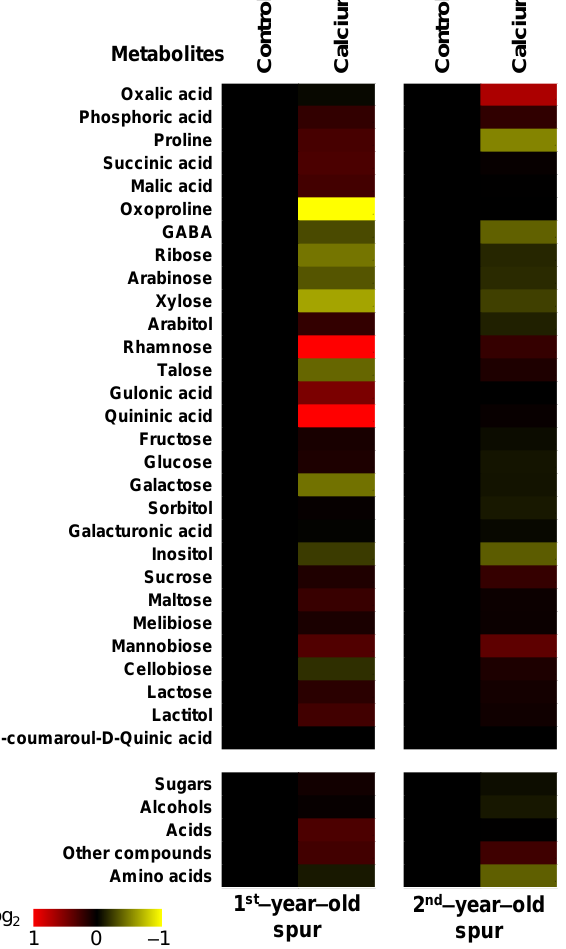
Figure 4. Heatmap diagram of primary polar metabolites in full ripe sweet cherry skin (black skin colour) between control and high-dose calcium (1M CaCl 2 ) treatment as well as between 1- and 2-year-old spurs. The red colour indicates an increase and the green colour a decrease of the metabolite’s abundance in response to treatment (1M Ca). Data of metabolite relative abundance are provided in Table S3.